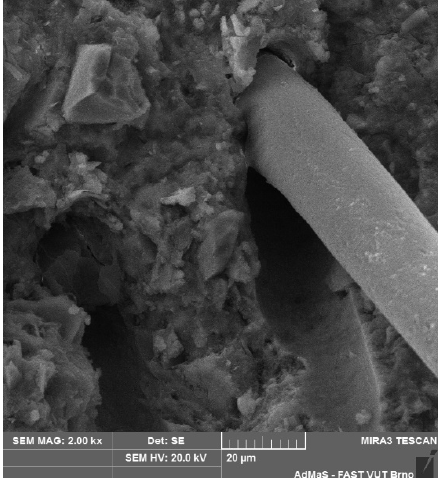
Figure 10. REC 2–20 °C (500×).